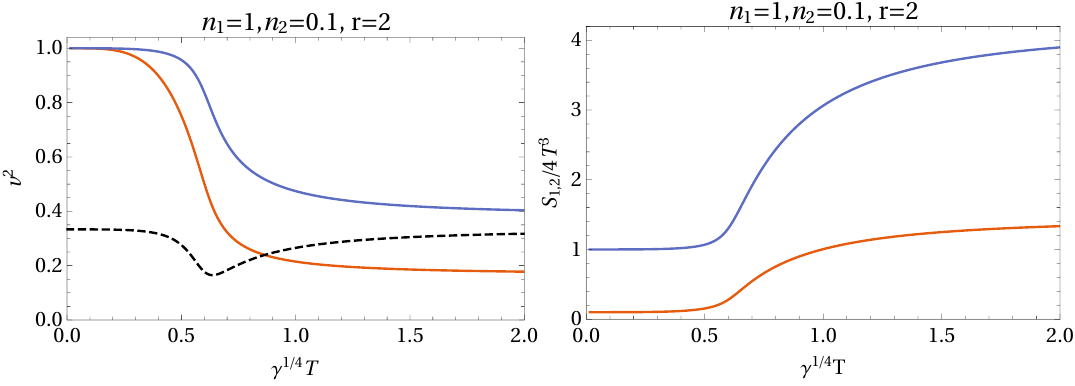
Figure 4 . Unequal systems with n 1 = 1 ; n 2 = 0 : 1 and r = 2. Left panel: light-cone velocities squared in the two subsystems ( v 2 : upper, blue line, ~ v 2 : lower, red line) compared to c 2 black line). Right panel: entropies of the two subsystems ( S 1 : upper, blue line, S 2 : lower, red